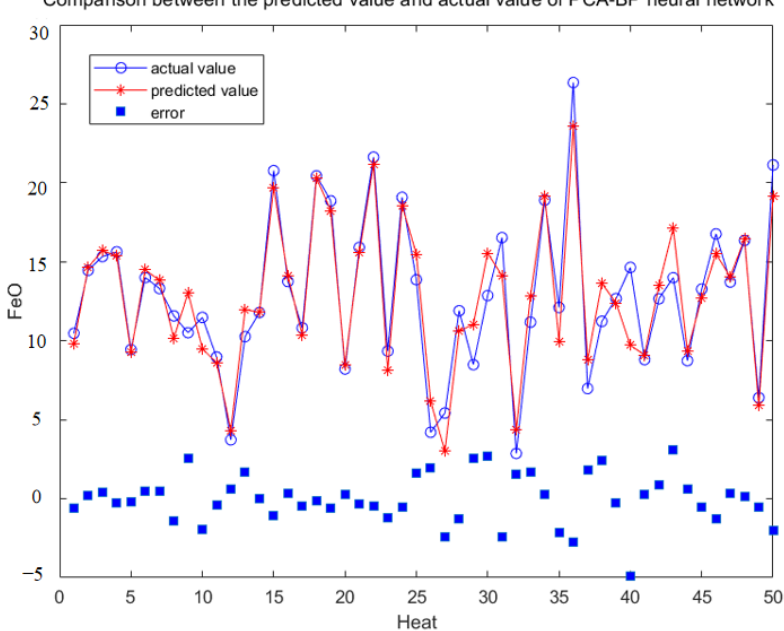
Figure 11. Comparison of predicted and actual FeO content of PCA-BP neural network.